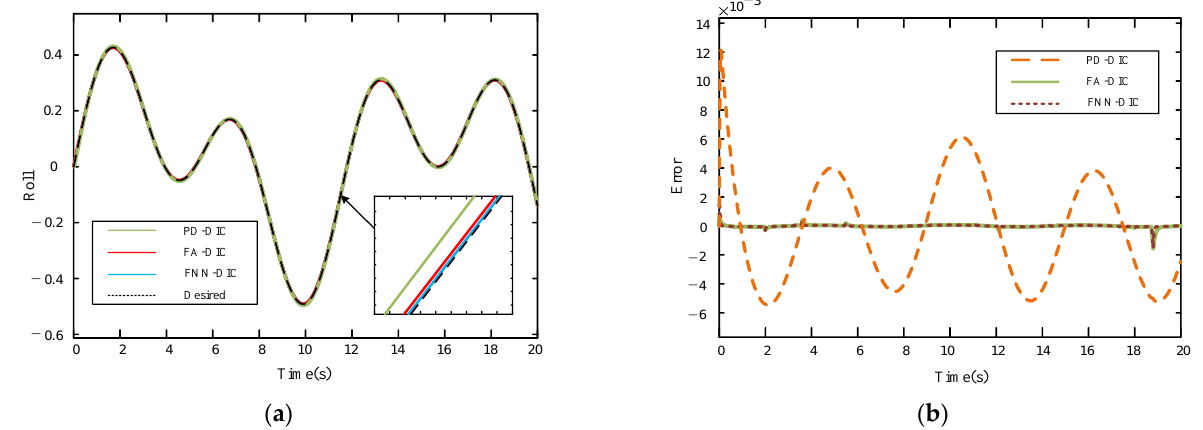
Figure 8. The results of the roll angle trajectory tracking. ( a ) Roll angle tracking track, and ( b ) roll angle tracking error.